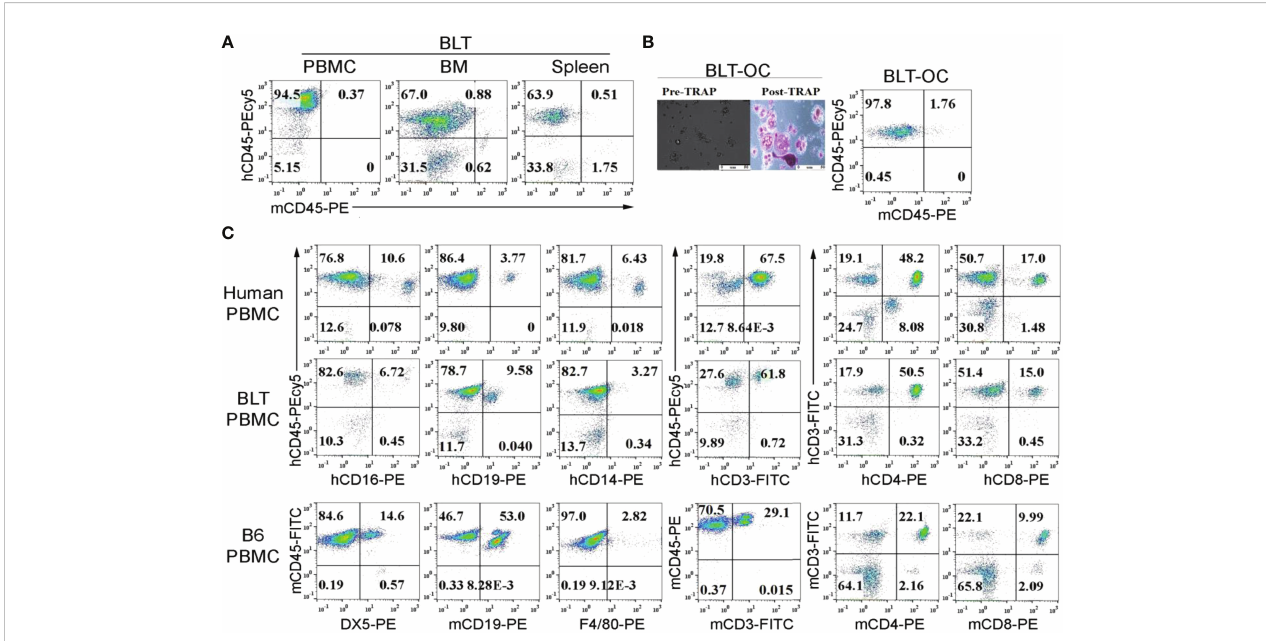
FIGURE 1 Surface expression of human and mouse CD45 on peripheral blood, bone marrow, splenocytes and bone marrow-derived osteoclasts of hu-BLT mice; comparison of immune cell percentages in human, WT mice and hu-BLT mice PBMCs. Hu-BLT mice acquired humanized hemato-lymphatic system by co-transplantation of human fetal liver and thymus fragments under the renal capsule of NOG/Scid g c-/- immune de fi cient NSG mice followed by the intravenous injection of autologous CD34+ hematopoietic cells. Eight weeks after tissue implantation, mice were euthanized and tissues were harvested to obtain single cell suspension. PBMCs, bone marrow (BM), and spleen of hu-BLT mice were analyzed for human and mice CD45+ immune cells using fl ow cytometric analysis (A) . Hu-BLT mice BM isolated monocytes were used to generate osteoclasts (OCs) for 21 days as described in Materials and Methods section. On day 21, hu-BLT OCs were washed with 1 X PBS before the pictures were taken by Leica DMI 6000B inverted microscope. Hu-BLT OCs were then treated with Fast Garnet GBC and sodium nitrate (1:1), incubated at 37 degree C for one hour, cells were rinsed and treated with hematoxylin for two mins before pictures were taken by Leica DMI 6000B inverted microscope. Pre- and Post-TRAP-stained pictures are shown in the fi gure. Hu-BLT OCs were analyzed for human and mice CD45+ immune cells using fl ow cytometric analysis (B) . Immune cell composition